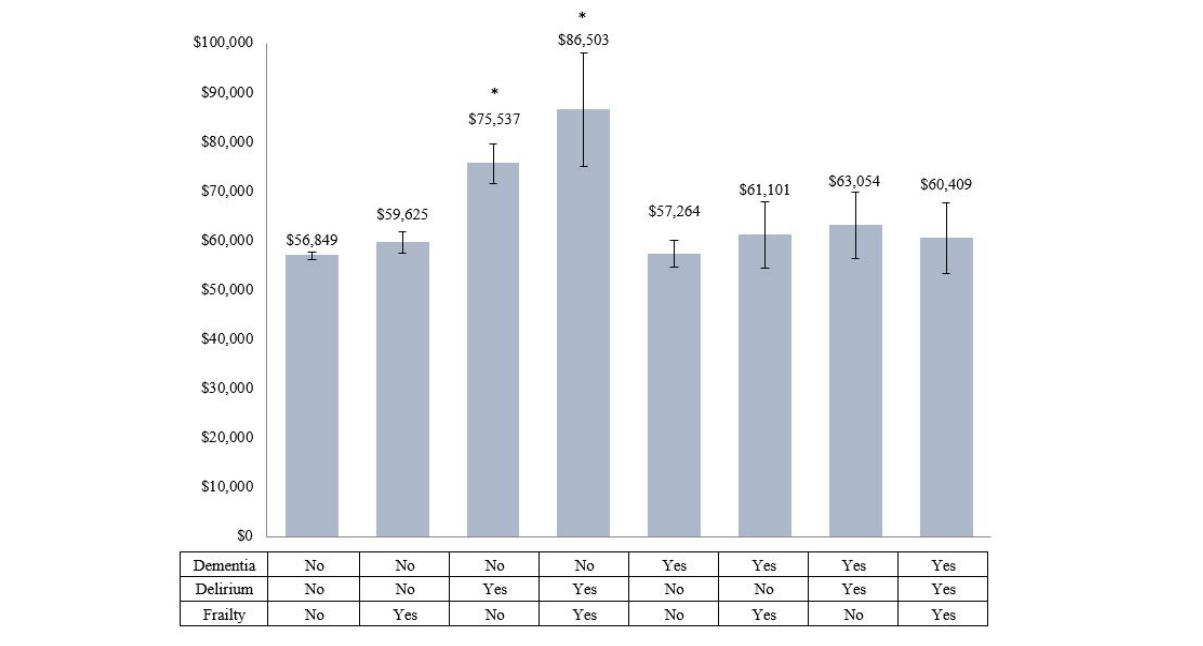
Figure 2. Predicted Average Total Hospital Cost of Each Condition from the Final Regression Model with Interaction Terms